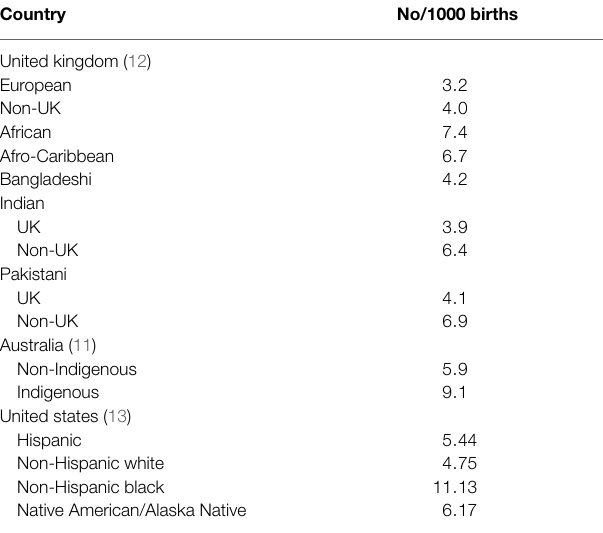
TABLE 2 | Incidence of stillbirths among different ethnic groups